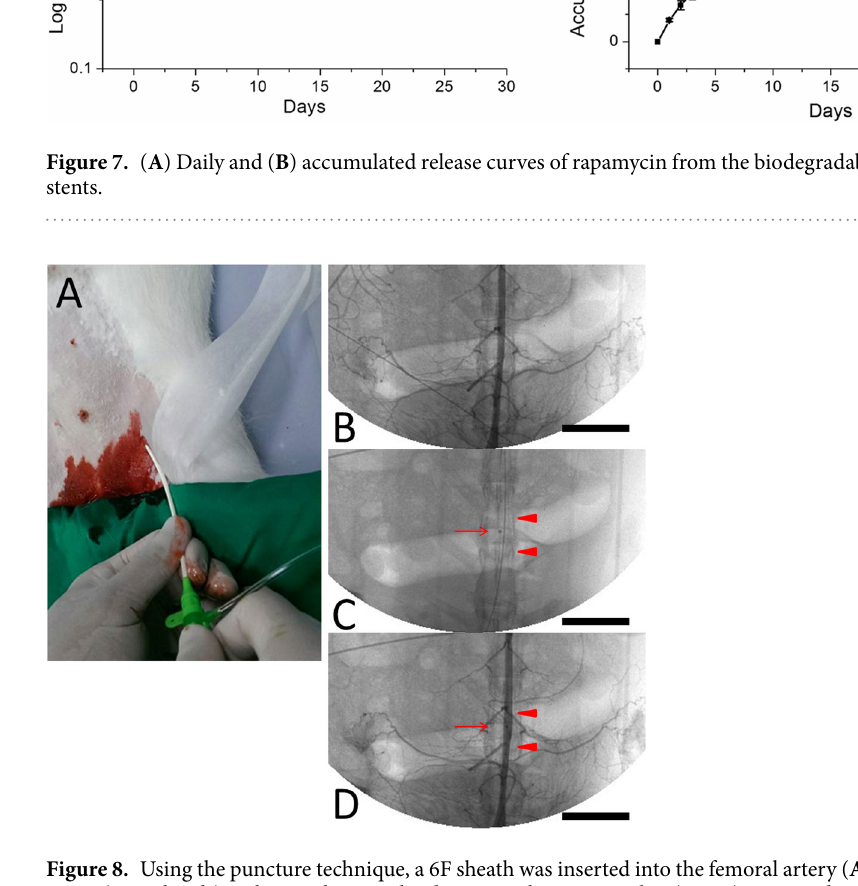
Figure 8. Using the puncture technique, a 6F sheath was inserted into the femoral artery ( A ). Biodegradable stents (arrowheads) with a single central radiopaque platinum marker (arrow), mounted and loaded with rapamycin nanofibers (6 μ g/mm 2 ) were implanted in the abdominal aorta of the rabbit ( B,C,D ) (Scale bar = 20